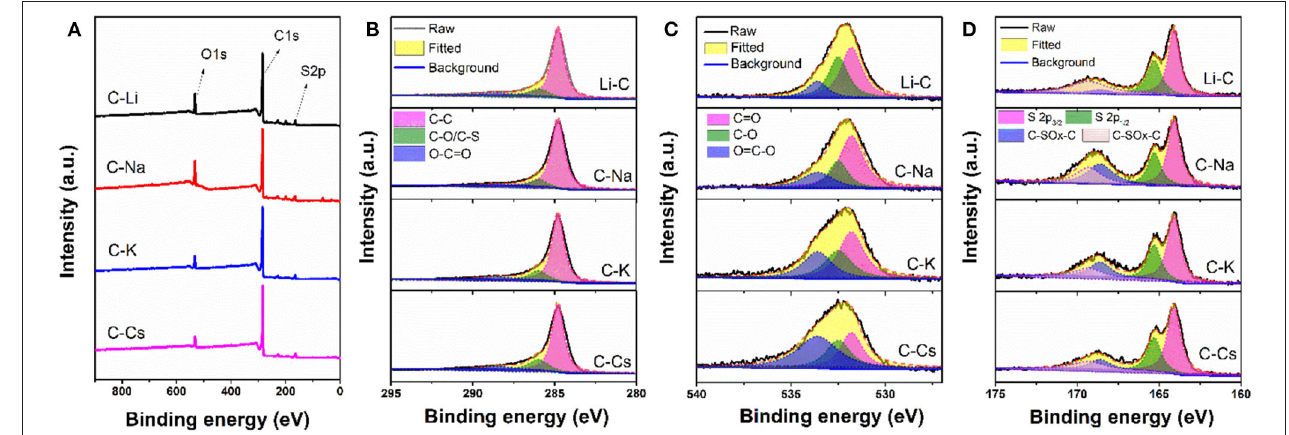
FIGURE 4 | X-ray photoelectron spectroscopy conveys (A) , C1s (B) , O1s (C) , and S2p (D) spectra for C-Ms.